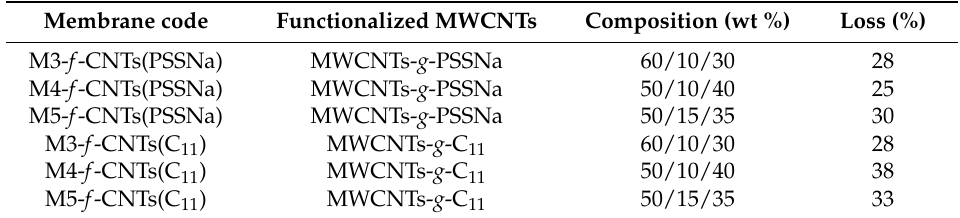
Table 2. Composition of blends and water loss of P(ethylene- co -AAc28)/P(SSNa- co -GMA0.1)/PEG and functionalized MWCNTs.